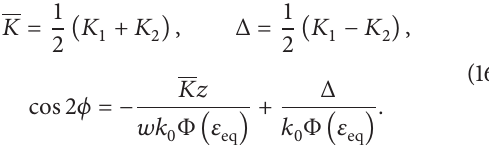
Figure 3: Boundary conditions and coordinate systems for each